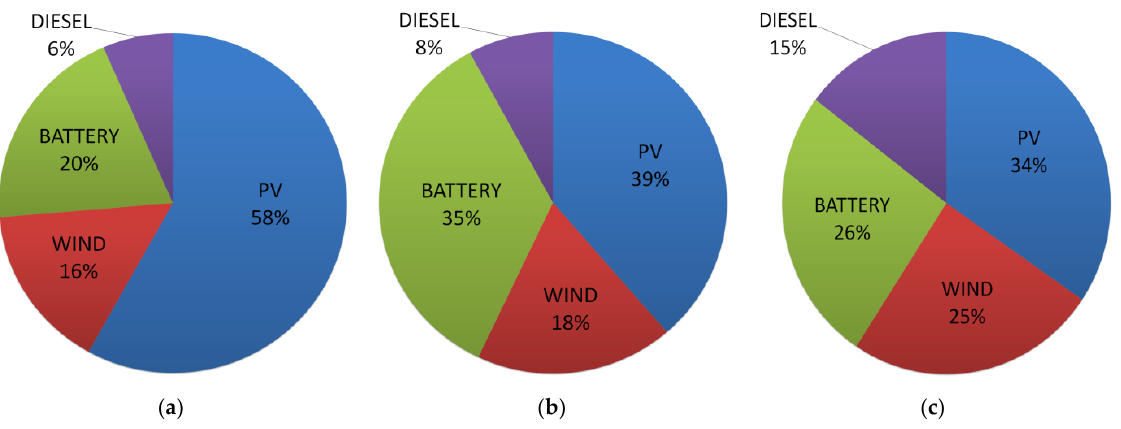
Figure 14. The annual contribution of energy generation by PV/WT/battery and DG for MODA. ( a